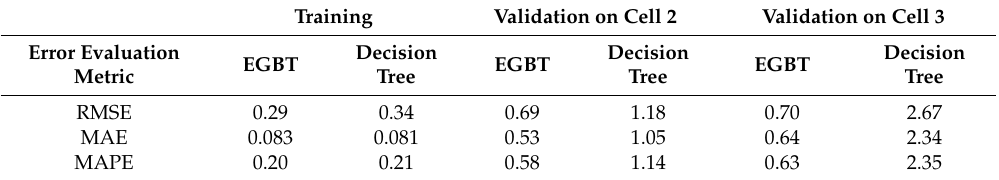
Table 8. Comparison between the decision tree and EGBT in the training and validation